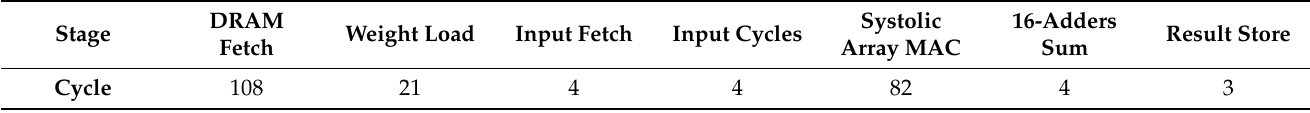
Table 9. Clock cycles for each pipeline stage in an example FC operation of Figure 2.